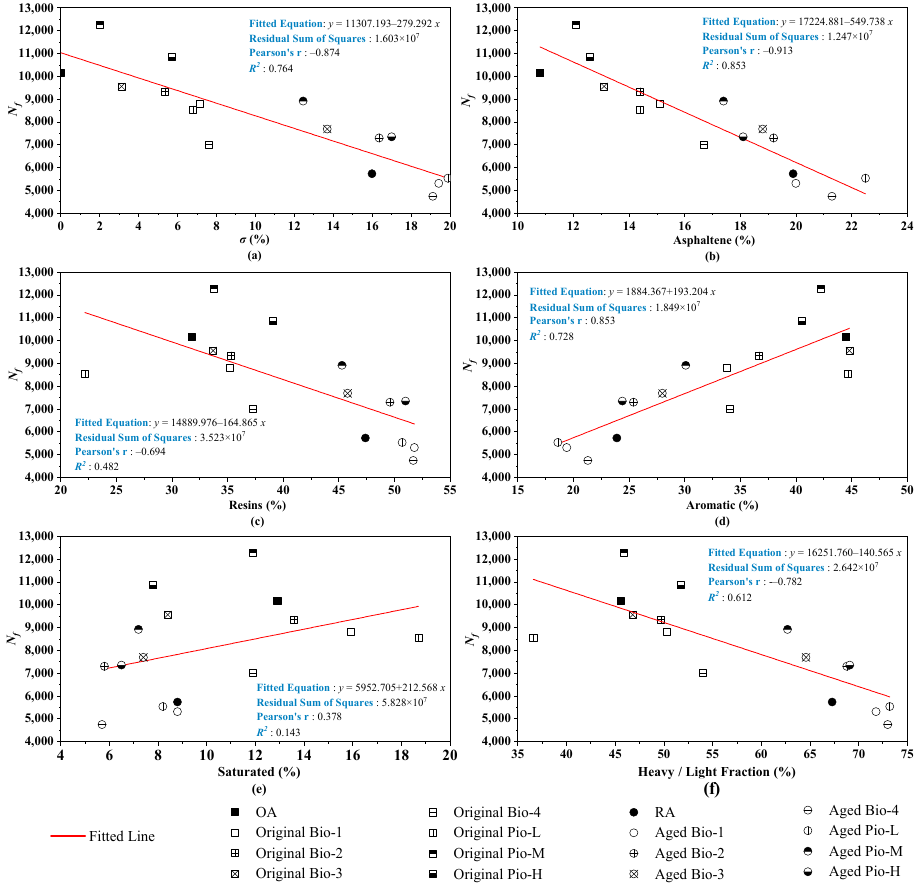
Figure 12. Correlation analysis between the N f and fraction indicators.( a ) σ ; ( b ) asphaltene; ( c ) resins; ( d ) aromatic; ( e ) saturated; ( f ) heavy/light.